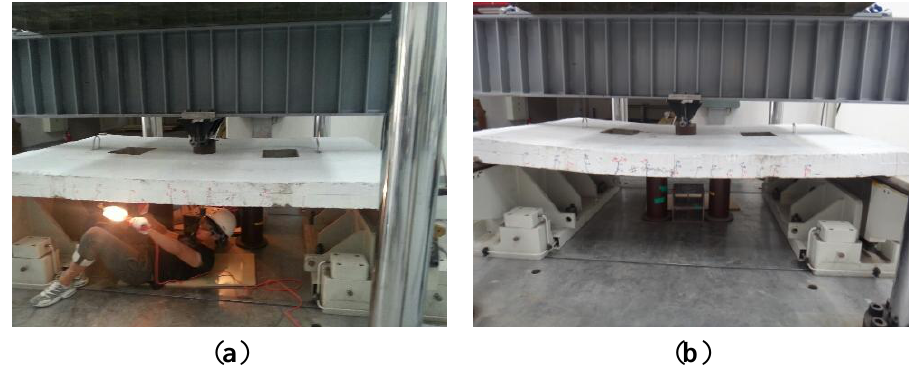
Figure 4. Test setups of ( a ) unstrengthening; ( b ) surround strengthening; ( c ) diagonal strengthening; ( d ) parallel strengthening for the various strengthening